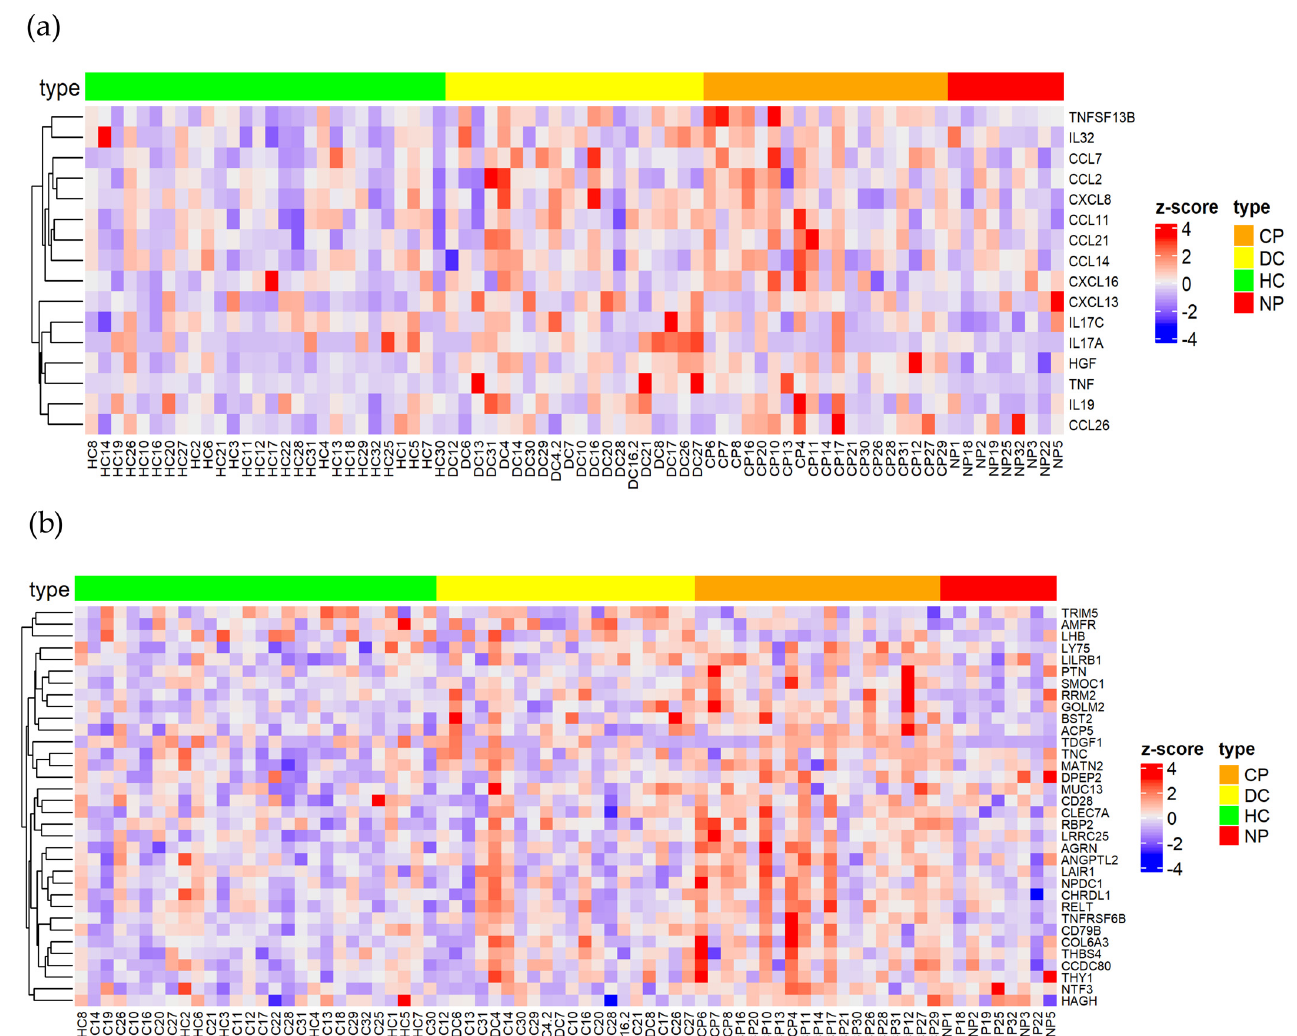
Figure 5. Identification of key immune signatures and novel proteins after SARS-CoV-2 infection. ( a ) Heatmap of differentially expressed cytokines and ( b ) novel protein changes among different clinical groups (patients with and without comorbidities, disease controls, and healthy controls) with z-score by row normalization and distributed by hierarchical clustering.